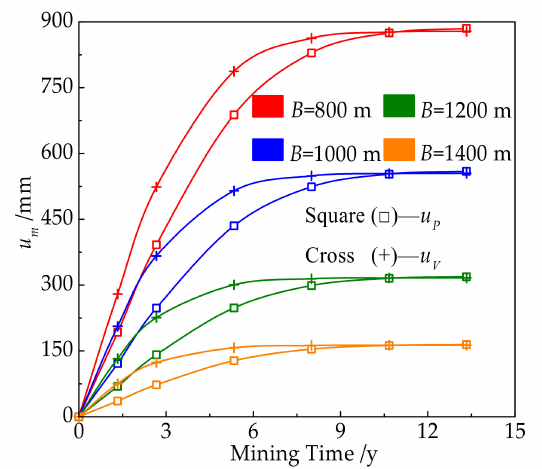
Figure 12. The variation curves of u m with the mining time.